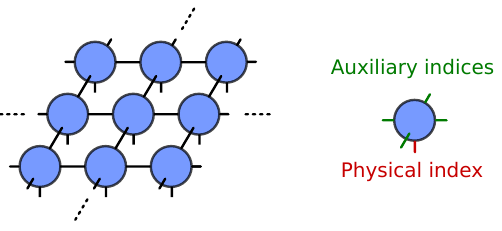
Figure 1: Left: part of an iPEPS for a square lattice. Right: physical and auxiliary indices; each leg corresponds to an index. Connected lines are summed